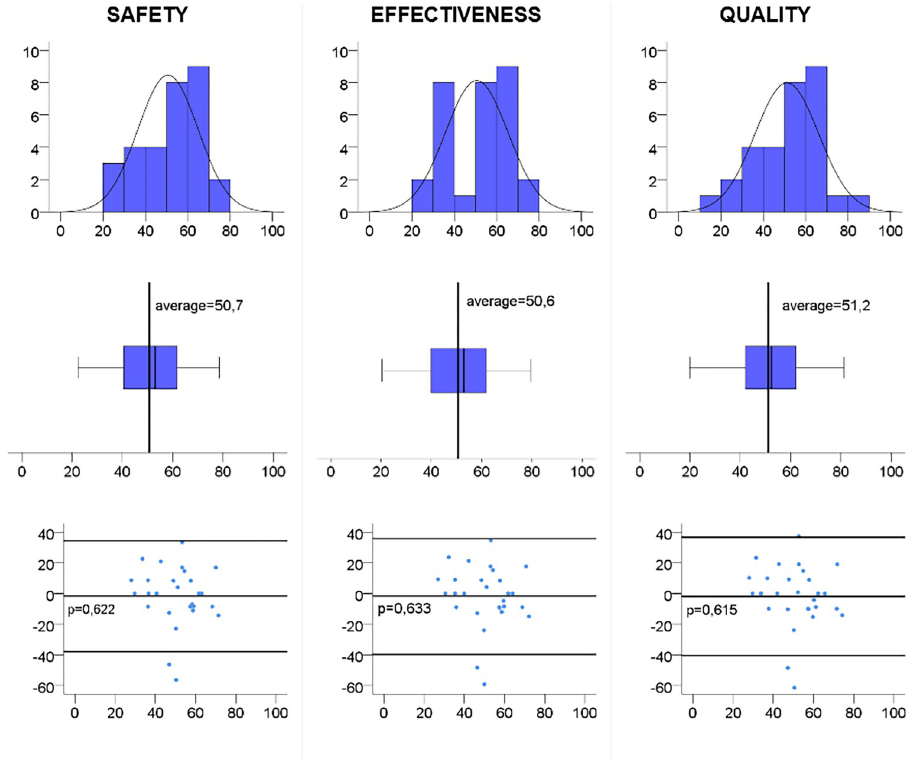
Fig 2. Matrix-plot for reliability and utility analysis of composite indicators. Thus, the Shapiro-Wilk test and intraclass correlation coefficient (ICC) test-retest were calculated from the quality indicator, resulting in p = 0.38 and ICC = 1.0,